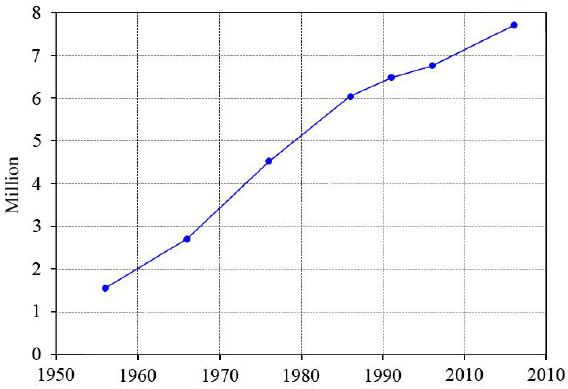
Figure 1. Population of Tehran Metropolitan Area during 1956-2006